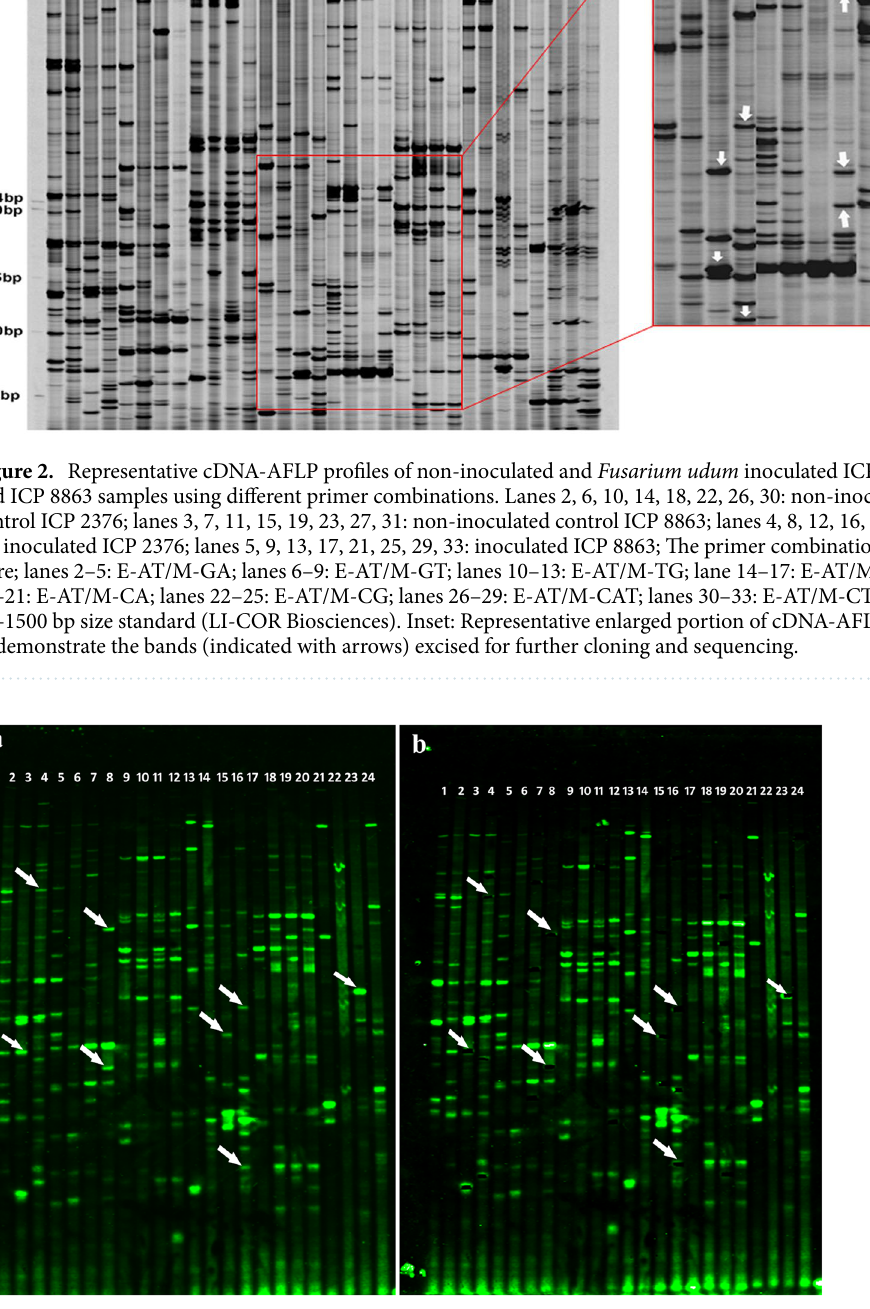
Figure 3. Representative cDNA-AFLP profiles of non-inoculated and Fusarium udum inoculated ICP 2376 and ICP 8863 samples using different primer combinations, photographed ( a ) before and ( b ) after excision of TDFs from the gel. Lanes 1, 5, 9, 13, 17, 21: non-inoculated control ICP 2376; lanes 2, 6, 10, 14, 18, 22: non-inoculated control ICP 8863; lanes 3, 7, 11, 15, 19, 23: inoculated ICP 2376; lanes 4, 8, 12, 16, 20, 24: inoculated ICP 8863; The primer combinations used were; lanes 1–4: E-AT/M-GA; lanes 5–8: E-AT/M-GT; lanes 9–12: E-AT/M-TG; lane 13–16: E-AT/M-TC; lane 17–20: E-AT/M-CG; lanes 21–24: E-ACT/M-GA. Arrows indicate some of the bands, ( a ) before and ( b ) after excision, used for further cloning and